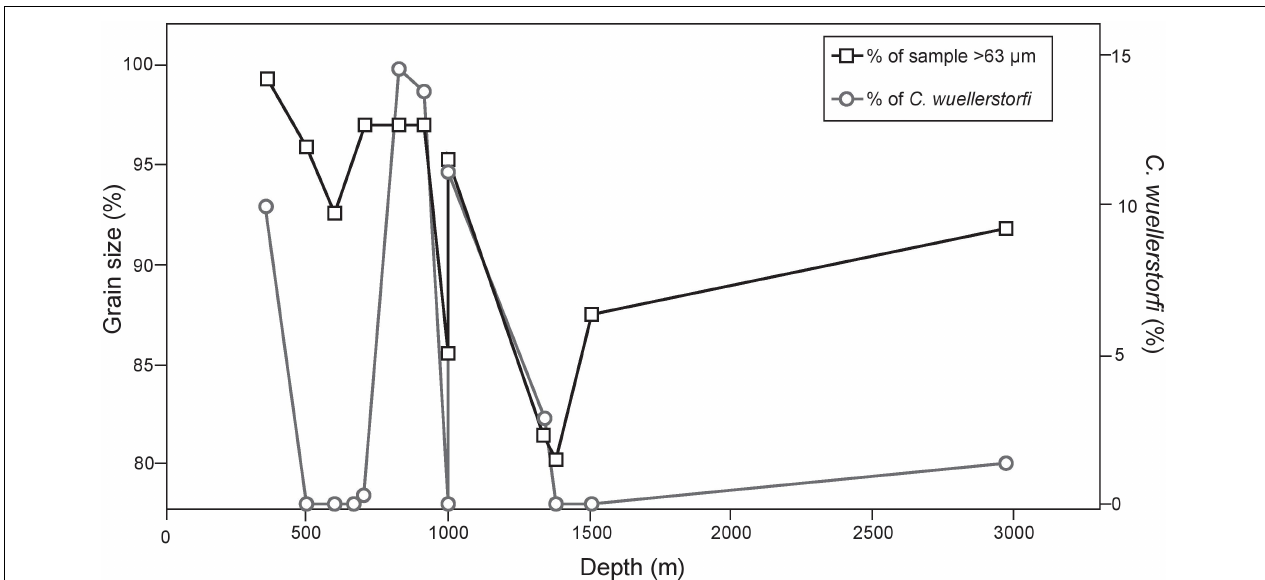
FIGURE 8 | Abundance of sand-sized particles or greater characterizing the substrate along with presence of C. wuellerstorfi at each depth. We demonstrate that substrates with greater concentrations of sand-sized particles may provide habitat stability for C. wuellerstorfi to persist, despite low bottom water oxygen